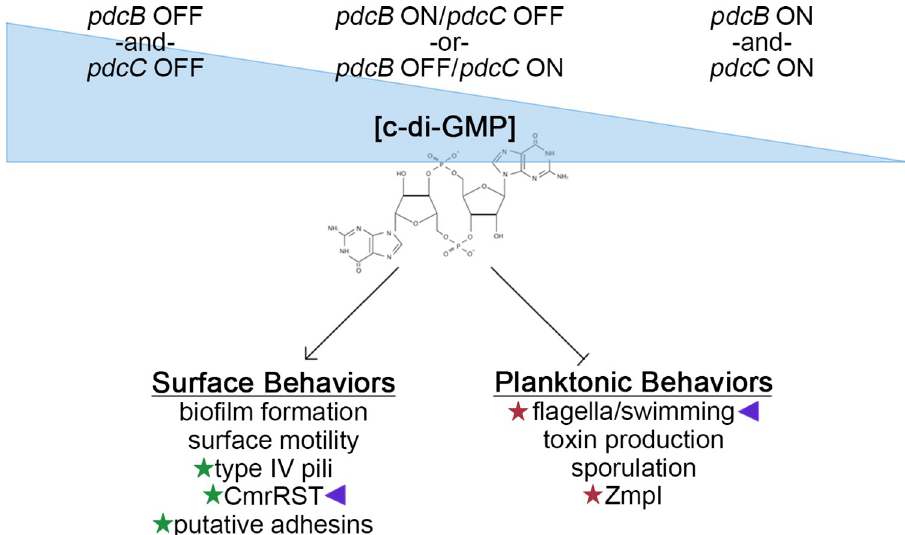
Fig 8. Model of PdcB and PdcC phase variation in the context of c-di-GMP signaling in C . difficile . Within the range of possible c-di-GMP concentrations established by c-di-GMP biosynthetic and hydrolytic enzymes, represented by the blue wedge, phase variation of PdcB and PdcC may shift c-di-GMP levels in a bacterial cell. A combination of pdcB ON and pdcC OFF or vice versa would maintain intermediate levels; switching of both to OFF would lead to accumulation of c-di-GMP; and switching of both to ON would deplete c-di-GMP. These switch combinations result in heterogeneity in intracellular c-di-GMP levels in the bacterial population and influence the phenotypes exhibited. Higher c-di-GMP concentrations favor surface-associated behaviors such as biofilm formation and surface migration which are in part mediated by type IV pili, CmrRST, and potentially putative adhesins. Lower c-di-GMP favors planktonic behaviors such as swimming motility, toxin production, sporulation, and the ZmpI metalloprotease proposed to cleave adhesins to release C . difficile from a surface/biofilm [31,34,50].Not shown, additional DGCs and c- di-GMP PDEs influence c-di-GMP levels. Green stars indicate factors whose transcription is directly up-regulated by class II c-di-GMP riboswitches; red stars, factors whose transcription is directly down-regulated by class I c-di-GMP riboswitches. Purple triangles denote factors that independently phase vary.